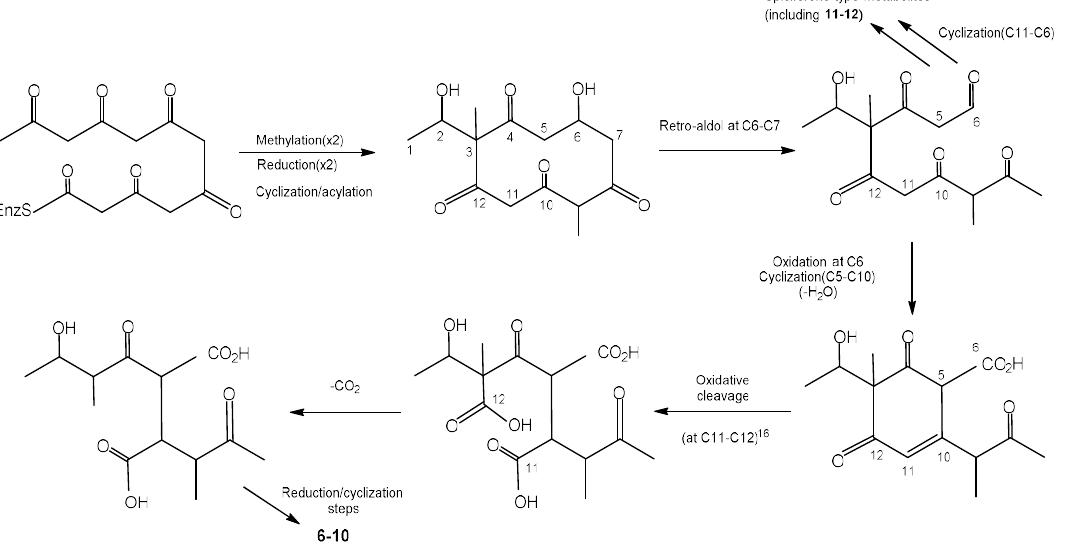
Figure 1. Synthesis pathway of disseminins and spiciferones.